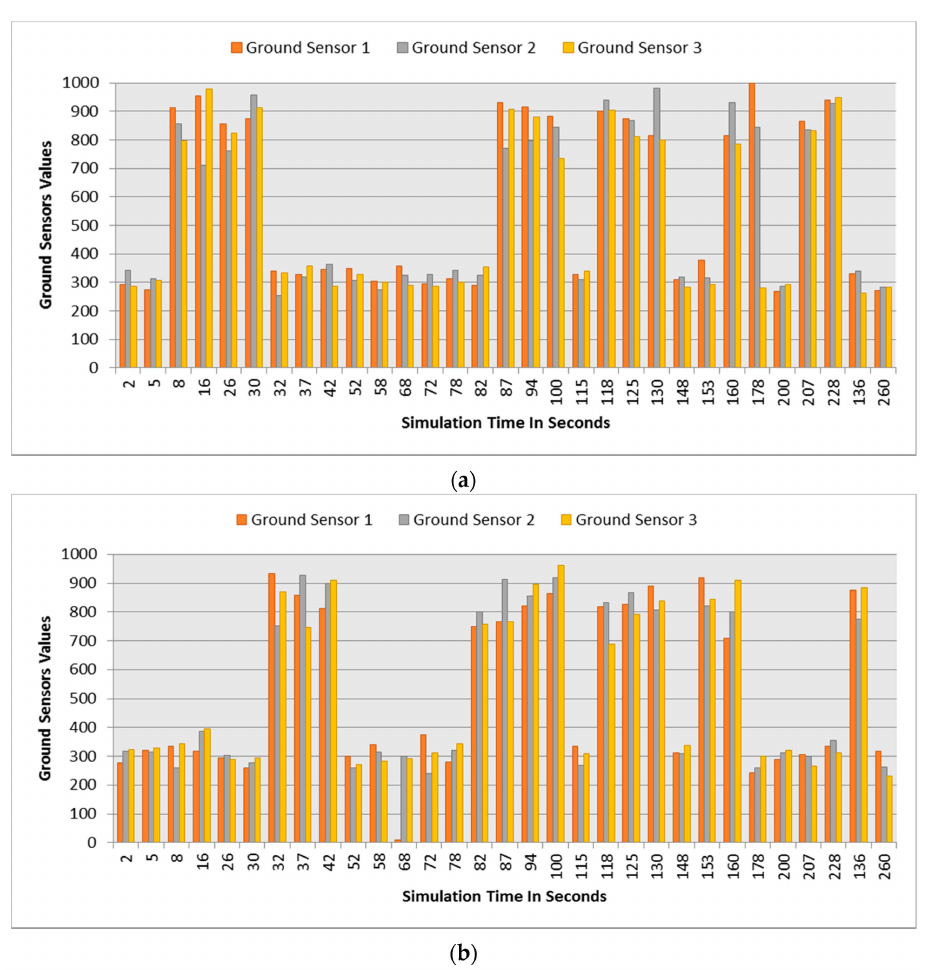
Figure 15. Ground sensors values for both robots at different simulation times. ( a ) Ground sensors values at different simulation times for robot 1; ( b ) Ground sensors values at different simulation times for robot